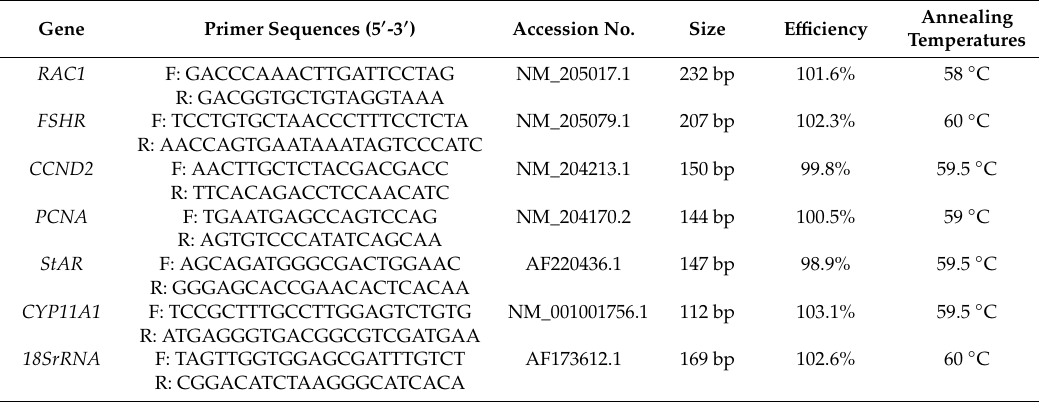
Table 1. List of primers used for Quantitative Real-Time Polymerase and Chain Reaction (RT-qPCR). Gene Primer Sequences (5 (cid:48) -3 (cid:48)